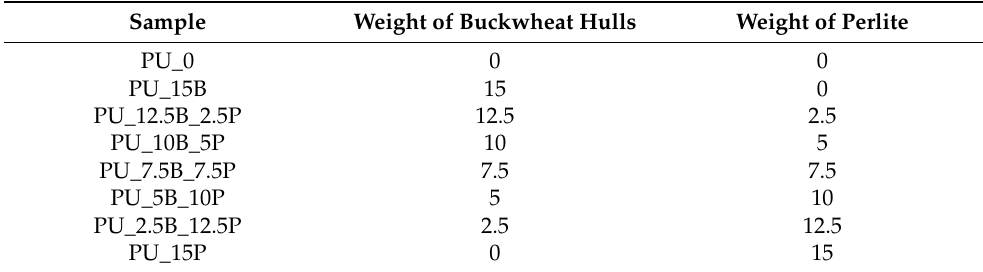
Table 1. The flame retardants added to the foam during synthesis in parts by weight per 100 parts of polyol.